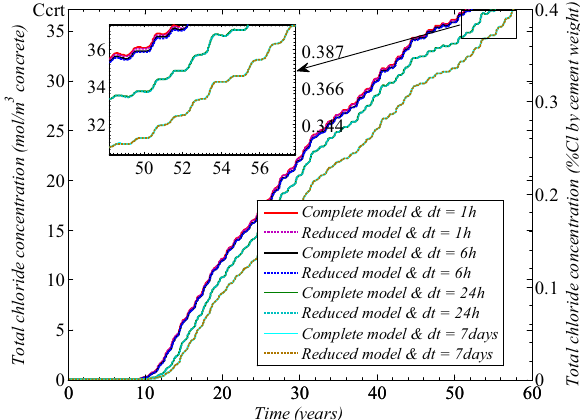
Fig. 8 Comparison of models considering various time-steps for a RC structure subjected to de-icing salt in Strasbourg,